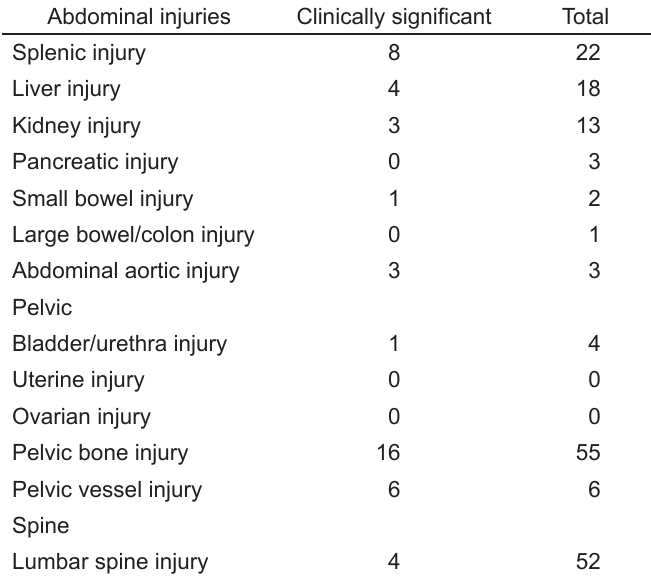
Table 3. Distribution of injuries to abdomen, pelvis, and spine.